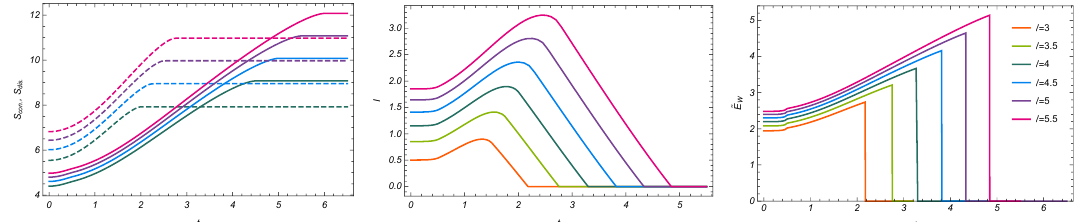
Figure 7 . Left : the HEE for connected (solid) and disconnected (dashed) con(cid:12)gurations for di(cid:11)erent values of h . At late times, the disconnected con(cid:12)guration is favored. Middle : the HMI as a function of time which vanishes at late times. Right : the EWCS as a function of boundary time which saturates to zero. Here we have set h =